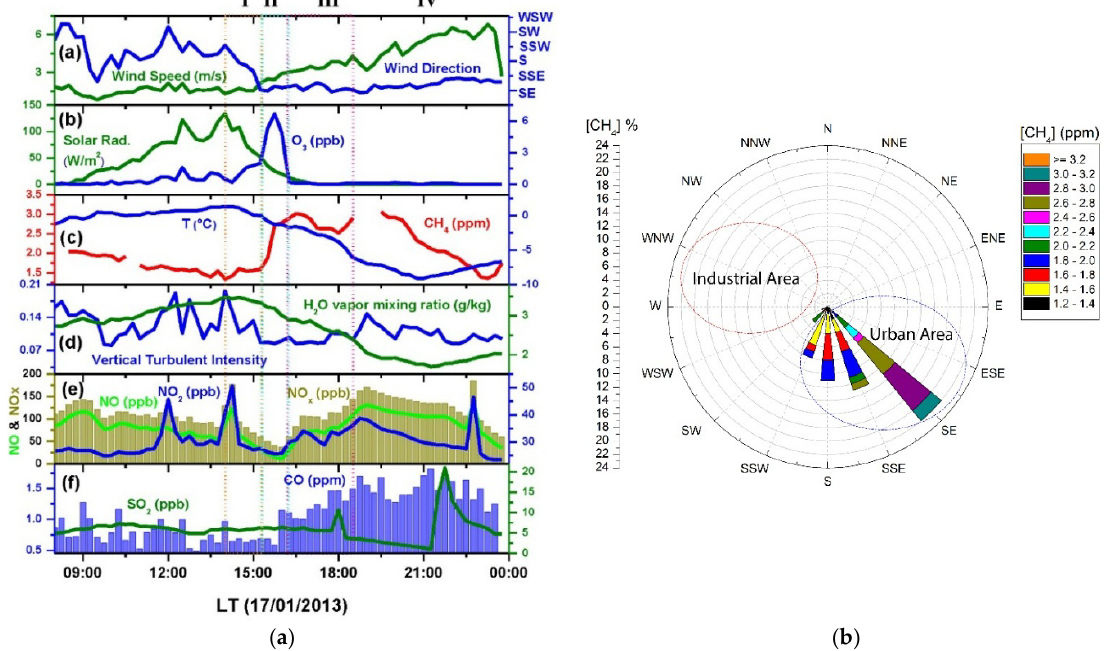
Figure 9. Time series (in local time, LT) measurements ( a ) and pollution ‐ concentration wind rose plot ( b ) showing the dependence of CH 4 concentration on the wind direction on 17th January